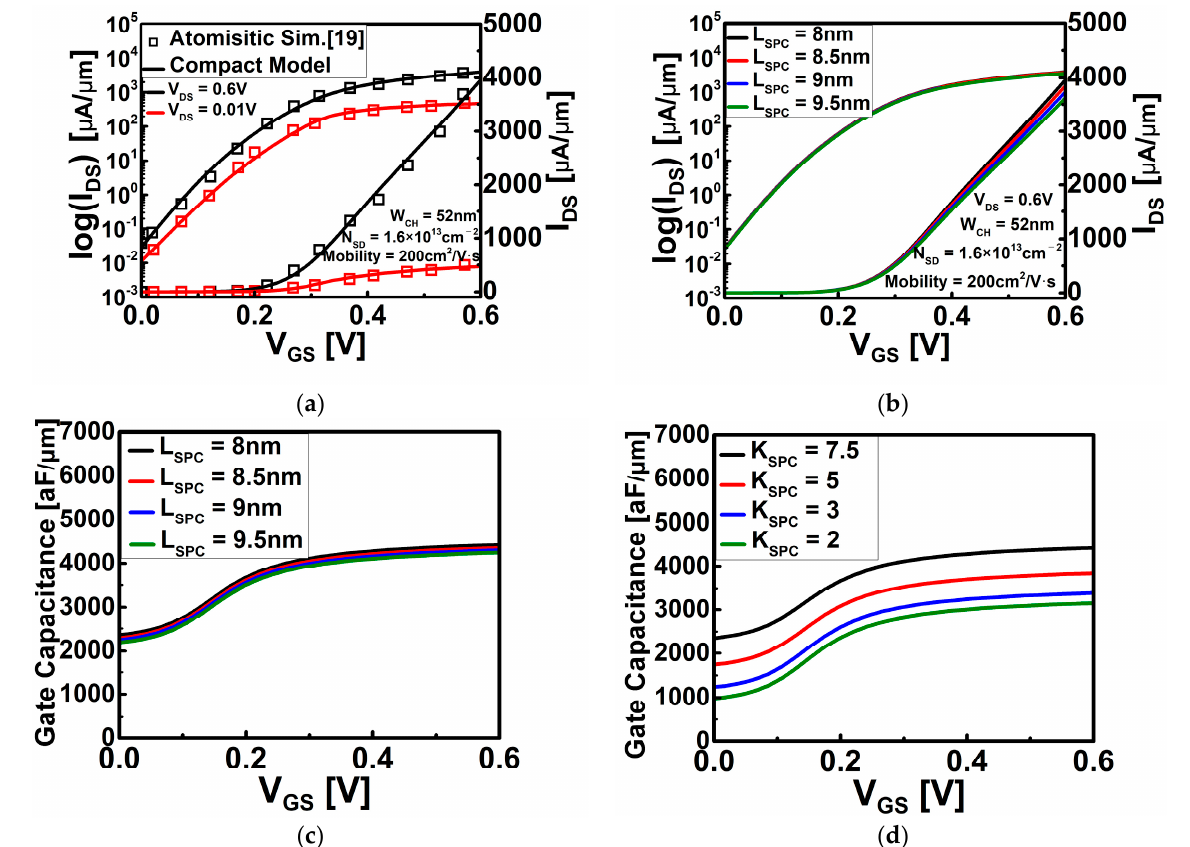
Figure 3. ( a ) I − V transfer curve of DG WS 2 -FET. The black line is when high voltage (V DS = 0.6 V) is applied, and the red line is when the low voltage (V DS = 0.01 V) is applied; ( b ) I − V transfer curve according to L SPC when high voltage applied; ( c ) gate capacitance according to L SPC ; and ( d ) gate capacitance according to K SPC .